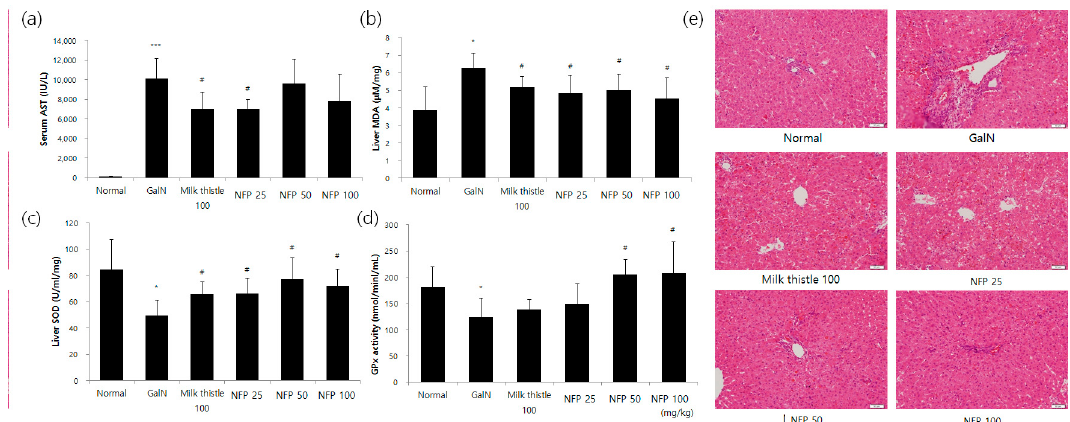
Figure 5. E ff ects of NFP on liver functions, oxidative stress markers, and histopathological changes (GalN, 400 mg / kg, single intraosseous (IP) dose). ( a ) Decreased aspartate transaminase (AST) activity in the NFP 25 mg / kg groups compared with the GalN control at # p < 0.05, *** p < 0.001. ( b ) Decrease in the lipid peroxidation product malondialdehyde (MDA) in the NFP 25, 50, and 100 mg / kg groups, compared with the GalN control at # p < 0.05. ( c, d ) Increase in the superoxide dismutase (SOD) (25, 50, and 100 mg / kg) and GPx (50 and 100 mg / kg) levels in the NFP groups compared with the GalN control at # p < 0.05. ( e ) NFP showed an absence of ballooning, inflammatory cells, regeneration of hepatocytes around the central vein, and also a slight congestion in the central vein. Data represent means ± SD ( n = 8). Magnification: 20 × , Scale bar: 50 µ